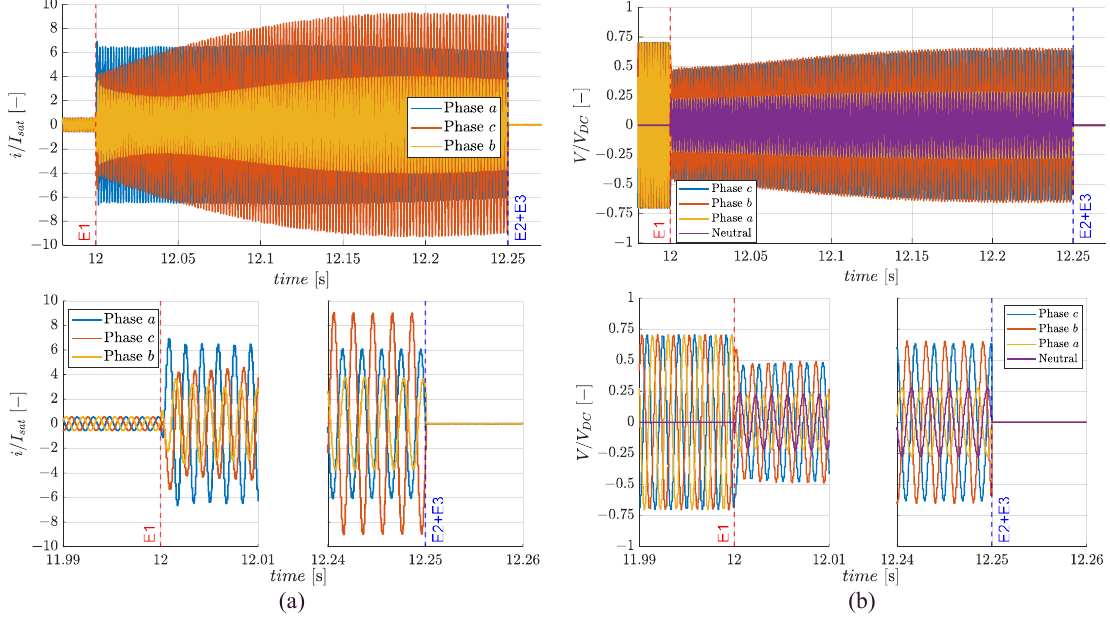
Figure 11. FEPS currents and voltages responses in climb with phase-to-ground fault on stator 2 (E1, E2 and E3 defined in Section 3.1): stator 2 currents ( a ) with 𝐼 (cid:3046)(cid:3028)(cid:3047) = 46 Arms ; stator 2 voltages ( b ) with 𝑉 (cid:3005)(cid:3004) = 36 V .